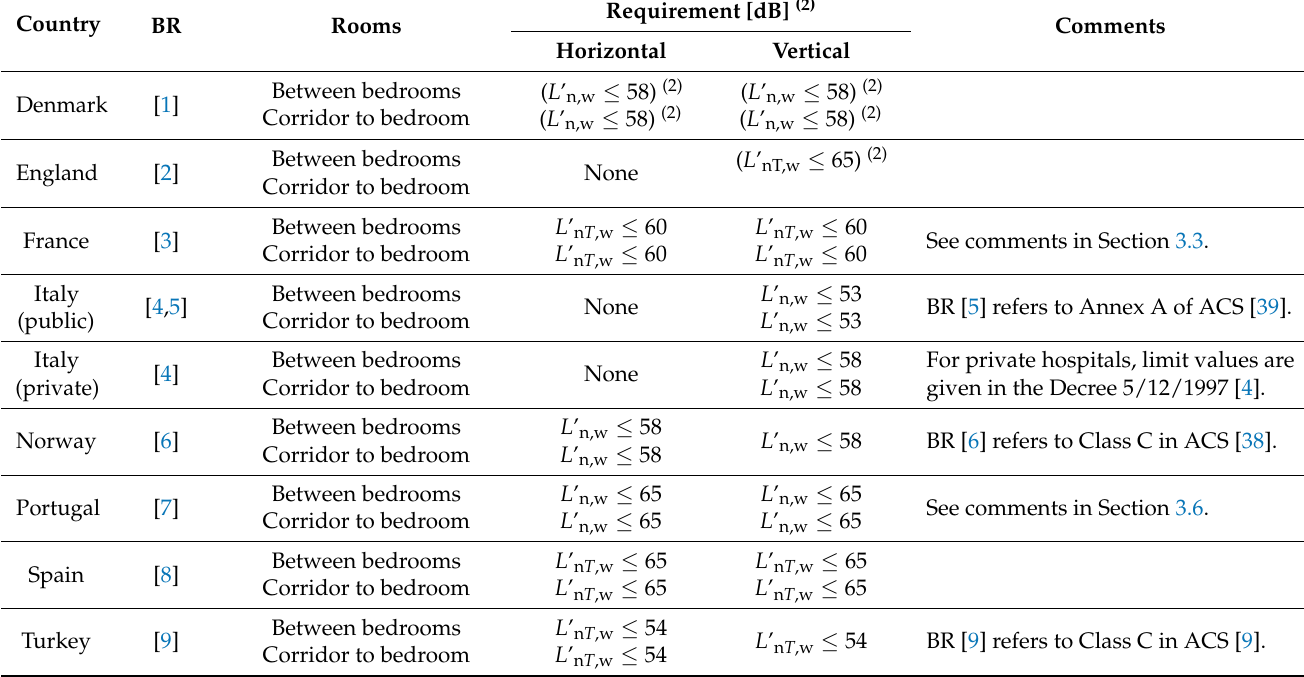
Table 3. Acoustic regulations for hospital bedrooms (1) —Impact sound insulation. November 2022.